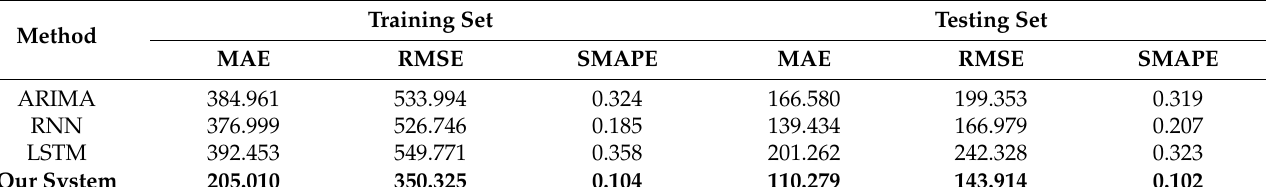
Table 6. Comparison of index values of each model on Chicago dataset.